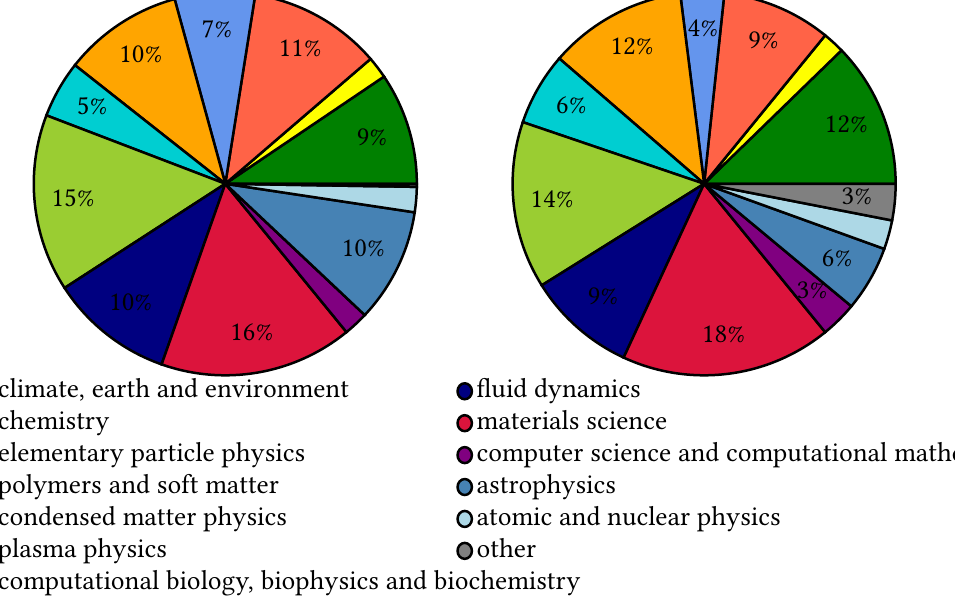
Figure 3: Allocated compute time (left) and number of projects (right) on JURECA by scientific field in the computing time period from the 1st of November 2015 to the 30th April 2016. Percentages are shown for shares above 3